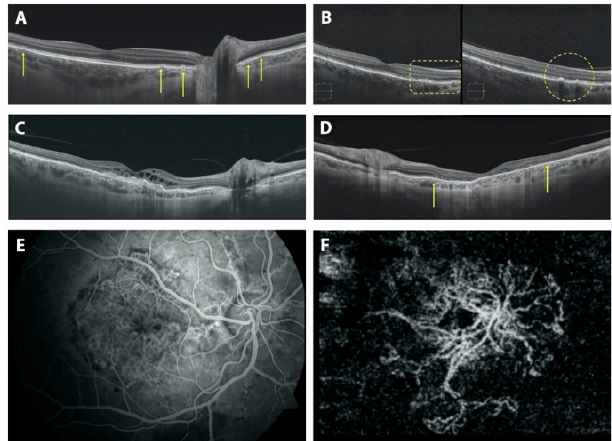
Figure 4. Optical coherence tomography scan showing: ( A ) angioid streaks of different size (yellow arrows); ( B ) retinal pigment epithelium and outer retina layer abnormalities (yellow contour) observed with scan passing at the fovea (left) or passing on dark macular deposits (right); ( C ) atrophy of the retinal pigment epithelium and retinal layers, and hyper-reflective abnormalities due to CNV; ( D ) macular atrophy in a patient affected by pattern dystrophy, with no signs of choroidal neovascularization; the interruptions of the outer nuclear layer are highlighted by the yellow arrows. ( E ) Fluorescein angiography and ( F ) optical coherence tomography angiography showing choroidal neovascularization.